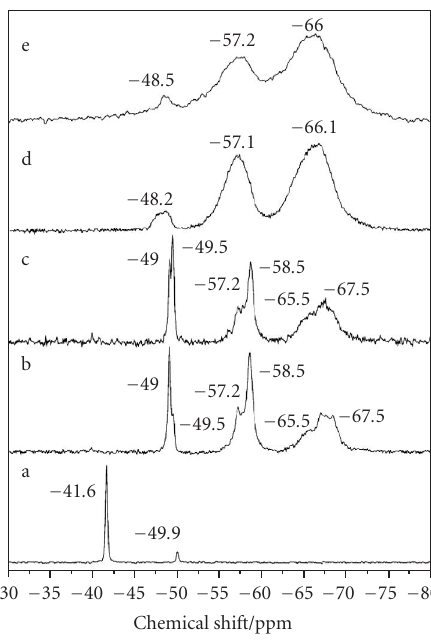
Figure 3: 29 Si NMR spectra of nonhydrolyzed a and hydrolyzed MTMSPI + I − in various stages of ageing: b: 2–3h (initial), c: 1 day, d: 1 week, and e: 2 weeks.